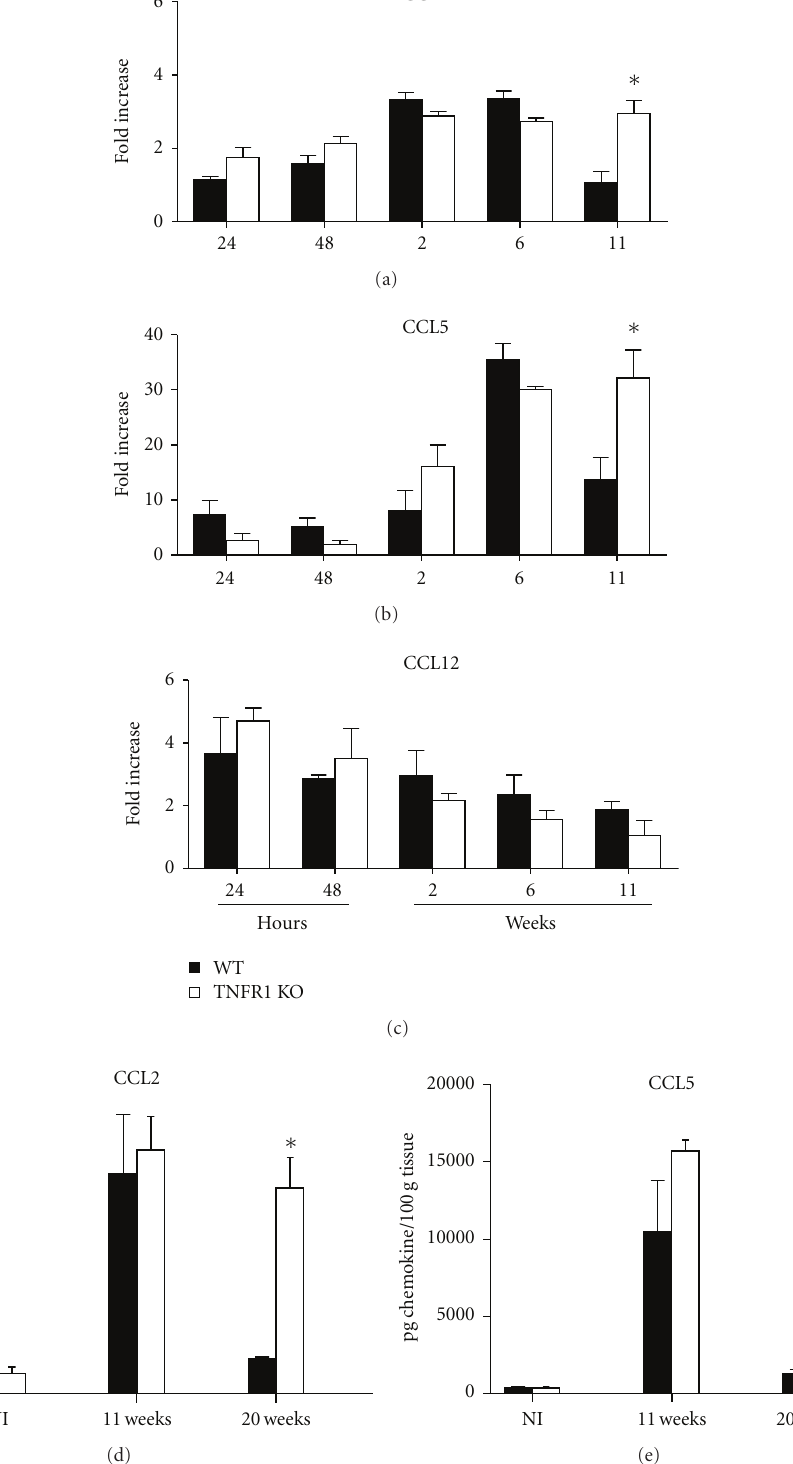
Figure 4: CCL2, CCL12, and CCL5 in lesions from WT and TNFR1 KO mice infected with L. major . Mice were infected in both footpads with L. major (1 × 10 6 ). At 24 and 48h and at 2, 6, and 11 weeks after infection, mice were killed, lesions were harvested and RT-PCR reactions were performed for chemokines. At 15 weeks, protein was assayed by ELISA. (a–c) Fold increase for CCL2, CCL12, and CCL5 mRNA, obtained by densitometry of bands in gels, as described in Section 2. (d–e) CCL2 and CCL5 determined by ELISA in footpads of na¨ıve mice (NI), and mice infected for 11 and 20 weeks. Data shown are from a single experiment representative of two separate experiments performed with four mice per group. ∗ P < 0 .